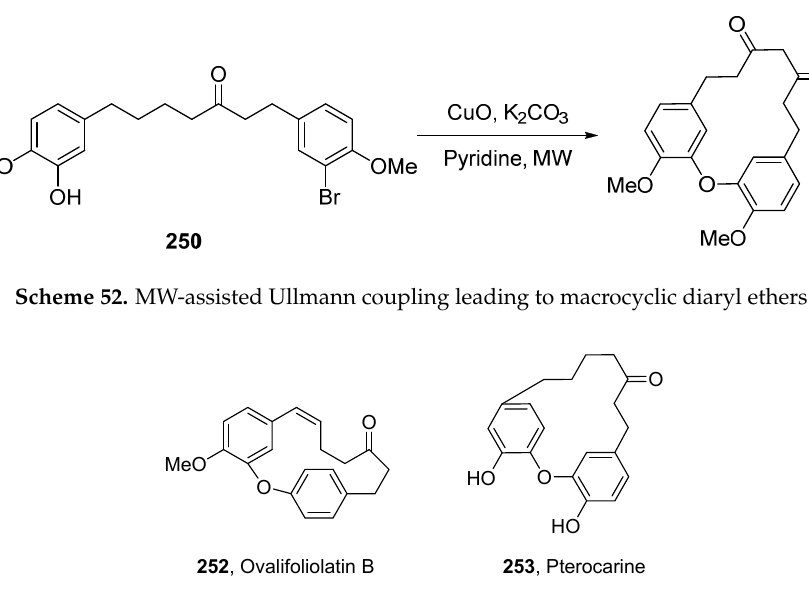
Scheme 53. MW-assisted synthesis of metallophthalocyanine.